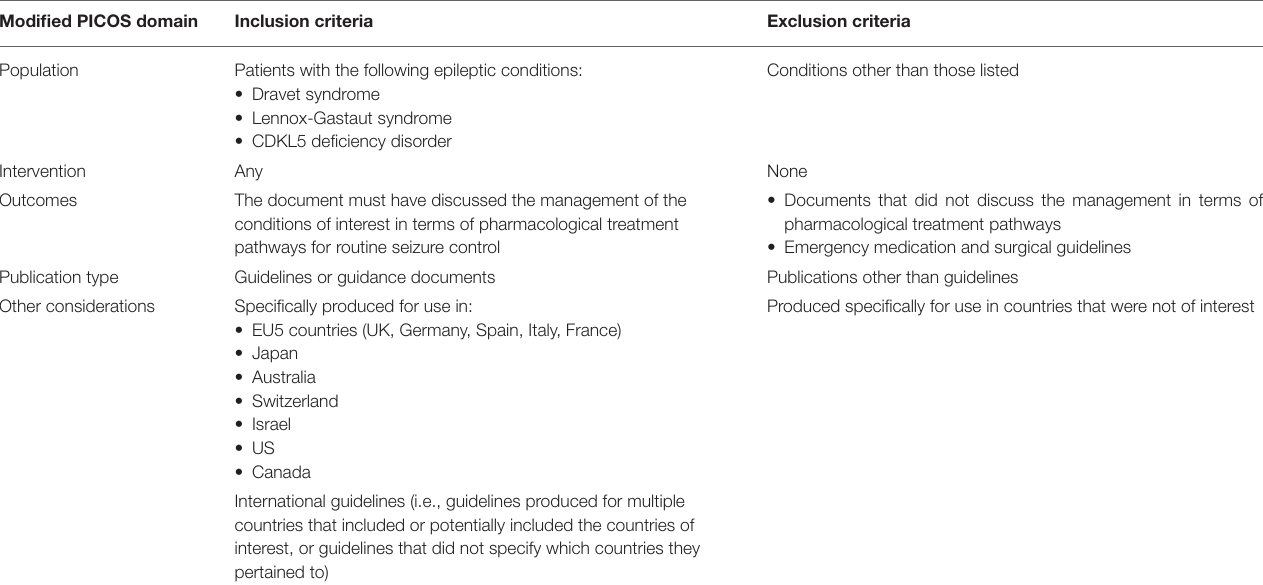
TABLE 1 | Eligibility